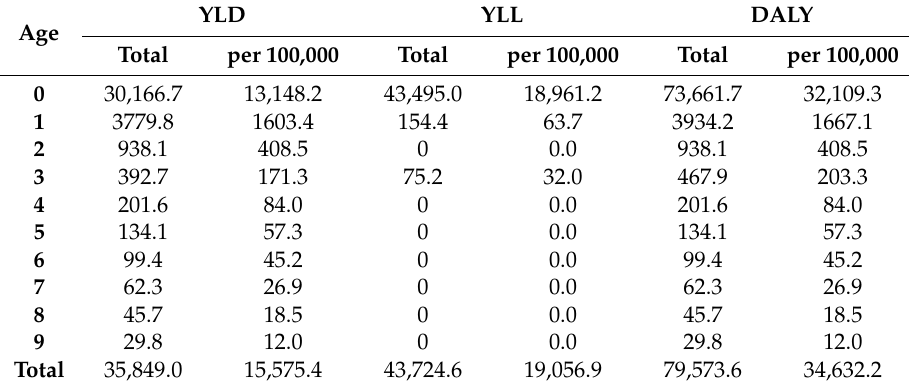
Table 5. DALY for preterm birth